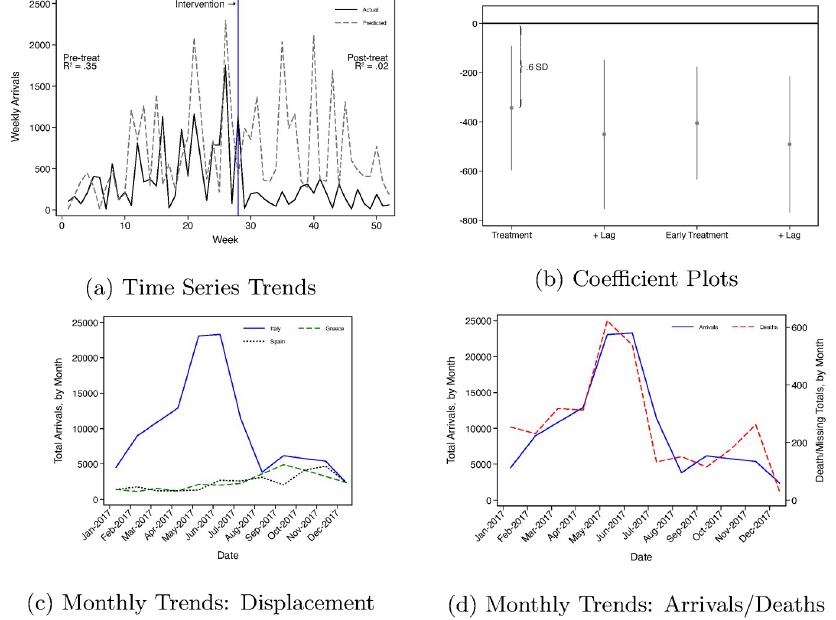
Fig 3. Impact of Italian intervention. (a) Weekly time series of actual (solid) and predicted (dashed) arrivals. Blue vertical bar indicates the week of the intervention. As expected, fit statistics suggest the predicted variation maps well to the pre-treatment period and poorly to the post-treatment period. (b) Regression-based estimates of the reduction in migrant flows following the intervention, relative the predicted flows from the prior year. Reduction is equivalent to 0.6 standard deviations. Outcome mean is -387.1; standard deviation is 595.2. 95% confidence intervals shown. (c) Monthly trends in migrant flows to three receiving countries. Notice large reduction corresponds to minor displacement through Spain and Greece. (d) Monthly trends in arrivals and deaths. Note strong correspondence between two trends (R 2 = .79).